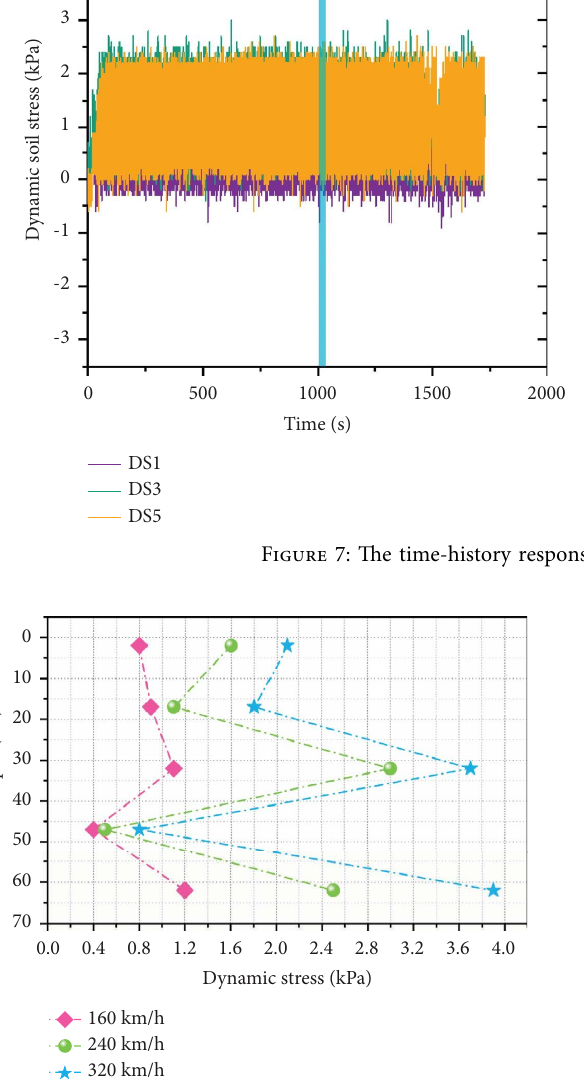
Figure 8: Te peak distribution curve of dynamic soil